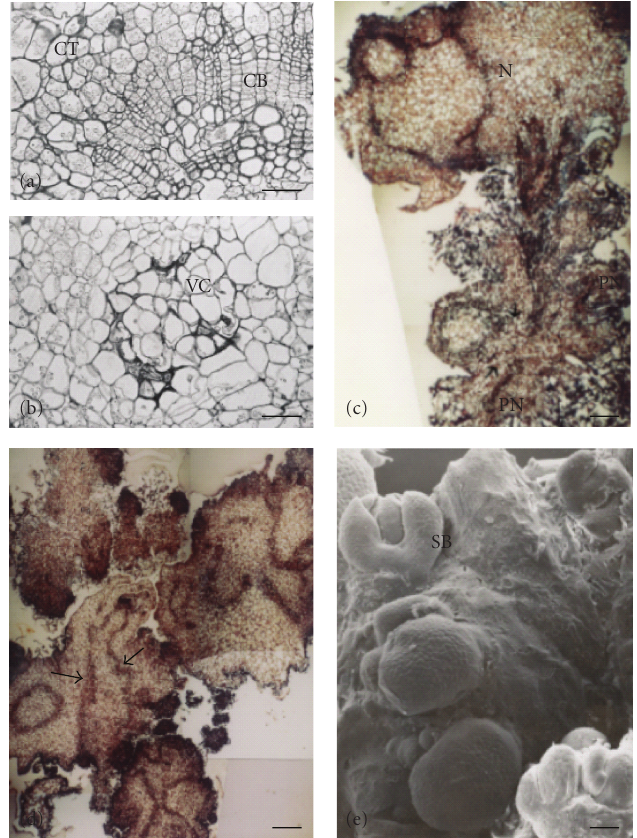
Figure 1: (a)–(e) Histological and ultrastructural features during organogenic nodule formation and plantlet regeneration from internodal explants cultured on Murashige and Skoog medium (Murashige and Skoog [22]) supplemented with 2mg/L benzylaminopurine and 0.05mg/L indole-3-acetic acid. (a) Bright field image of a cross-section of an internode after 15 days in culture showing divisions in cambial and cortical cells. The material was previously embedded in resin. (b) Nodule arising after 28 days in culture and showing a vascular center surrounded by a cortical parenchyma area. (c) Section showing prenodular and nodular structures arising from a single internode after 28 days in culture. Material was previously embedded in para ffi n wax. (d) Bright field image showing plantlet regeneration from nodules and separation of polycenter nodules into “daughter nodules.” Arrows point to vascular connections established between vascular bundles of nodule and growing plantlet. Material was previously embedded in para ffi n wax. (e) Scanning Electron Microscopy imaging showing multiple shoot bud regeneration from an organogenic nodule. Bar in (a) = 100 μ m; bar in (b) = 50 μ m; bars in (c) and (e) = 200 μ m; bar in (d) = 300 μ m. cb: cambial cells, ct: cortical cells, n: nodule, pn: prenodule, sb: shoot bud, s-, vc: vascular center. (c,d,e) were reproduced from